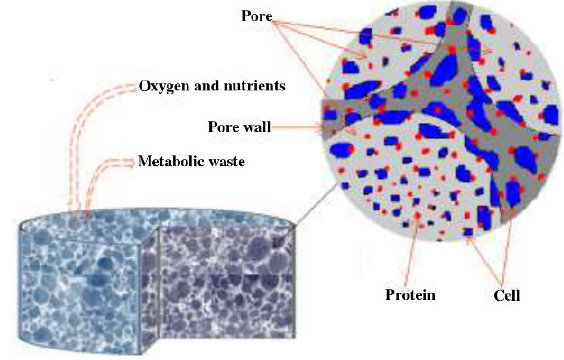
Figure 1. A schematic diagram of a porous biodegradable scaffold with cells and proteins incorporated to the structure.